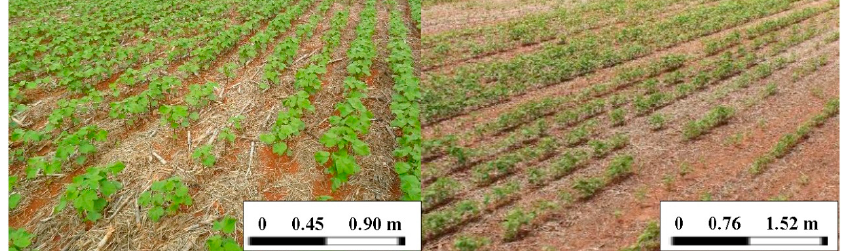
Figure 3. Uneven crop emergence and short scale variability at BBCH 51 in field NF1 during the 2013/2014 crop season and BBCH 51 in field CF3 during the 2014/2015 crop season.